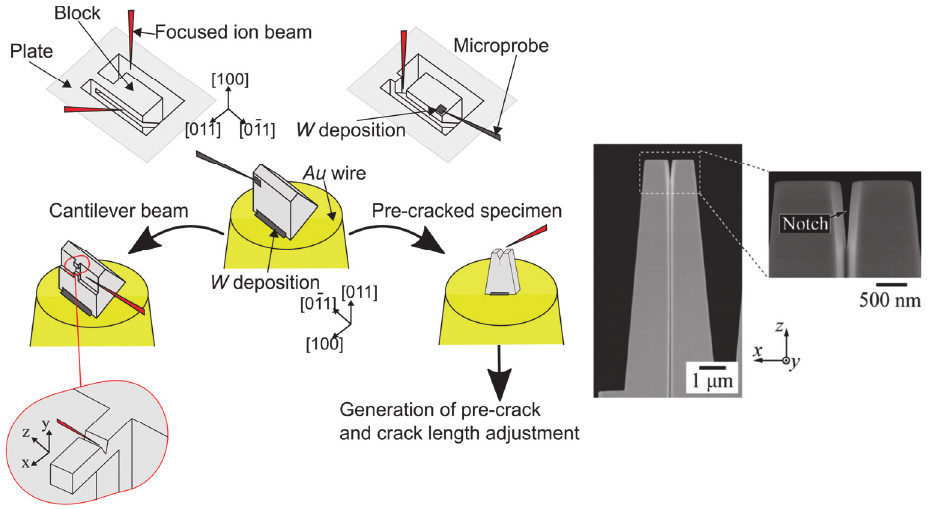
Figure 1: Example of fabrication of